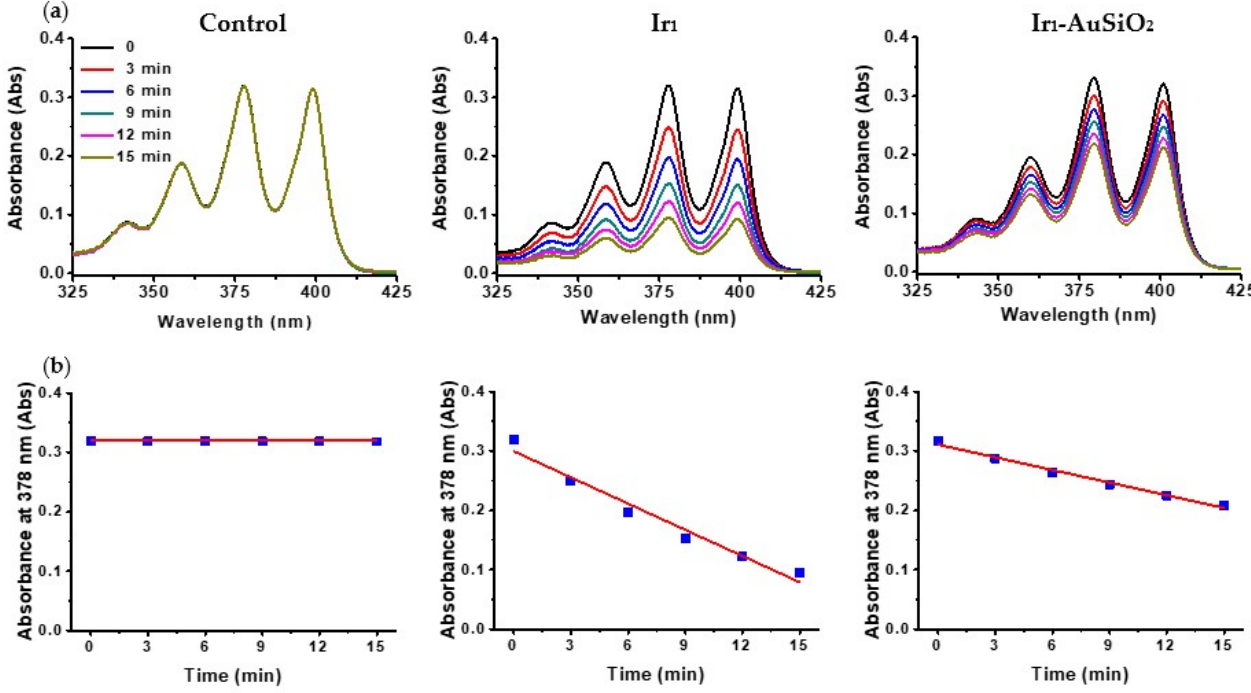
Figure 2. Comparative analysis of 1 O 2 generation detected by ABDA method. ( a ) Photobleaching of ABDA by 1 O 2 at different irradiation times (0–15 min) in water and in the presence of Ir 1 or Ir 1 -AuSiO 2 ([Ir 1 ] = 2 × 10 − 5 M). The experiments were carried out by using an excitation source at 365 nm-20 mW/cm 2 ; ( b ) plotting of ABDA absorption at 378 nm as a function of the illumination time.